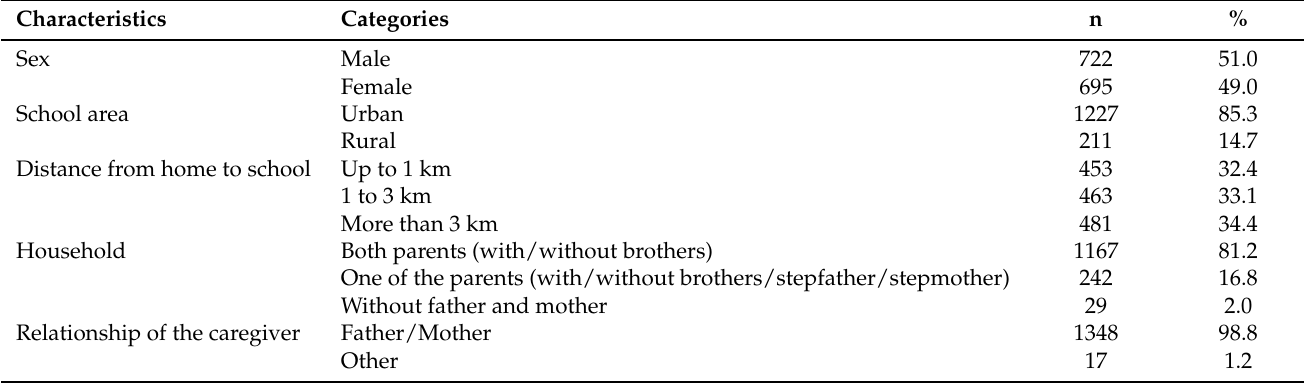
Table 1. Sociodemographic characteristics of the